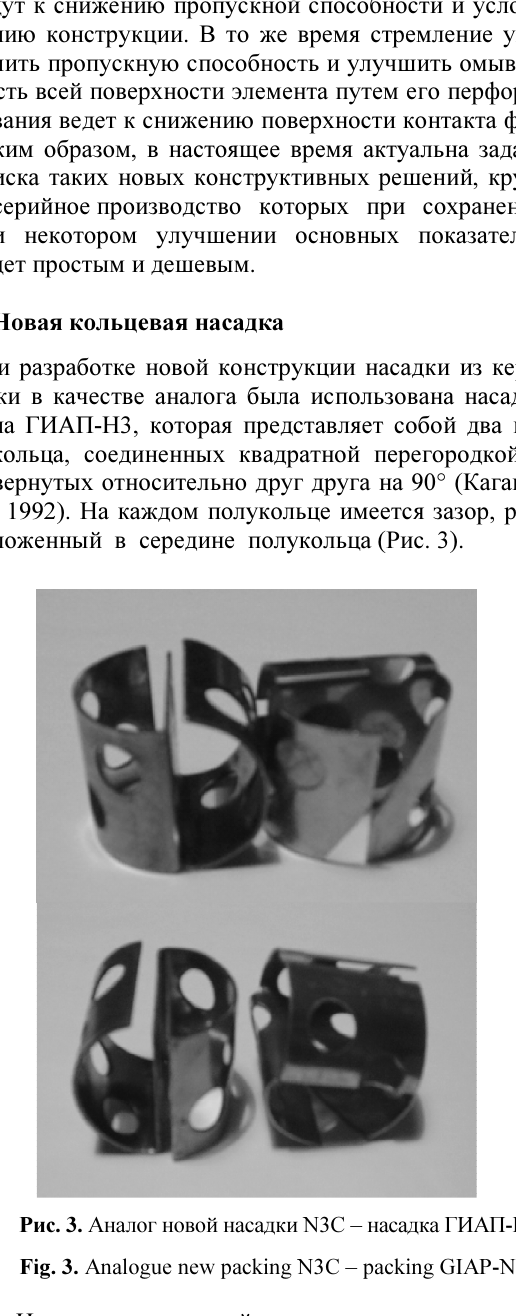
Fig. 3. Analogue new packing N3C – packing